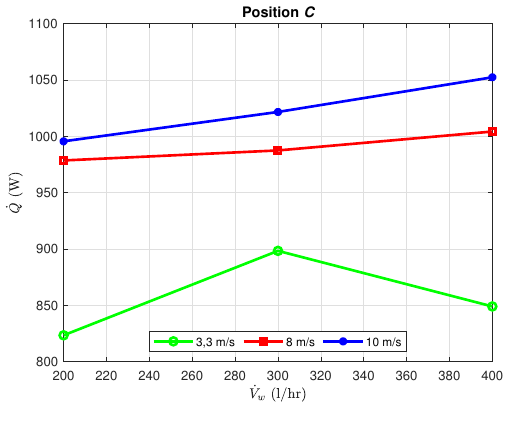
Figure 5. Results of the measurements.